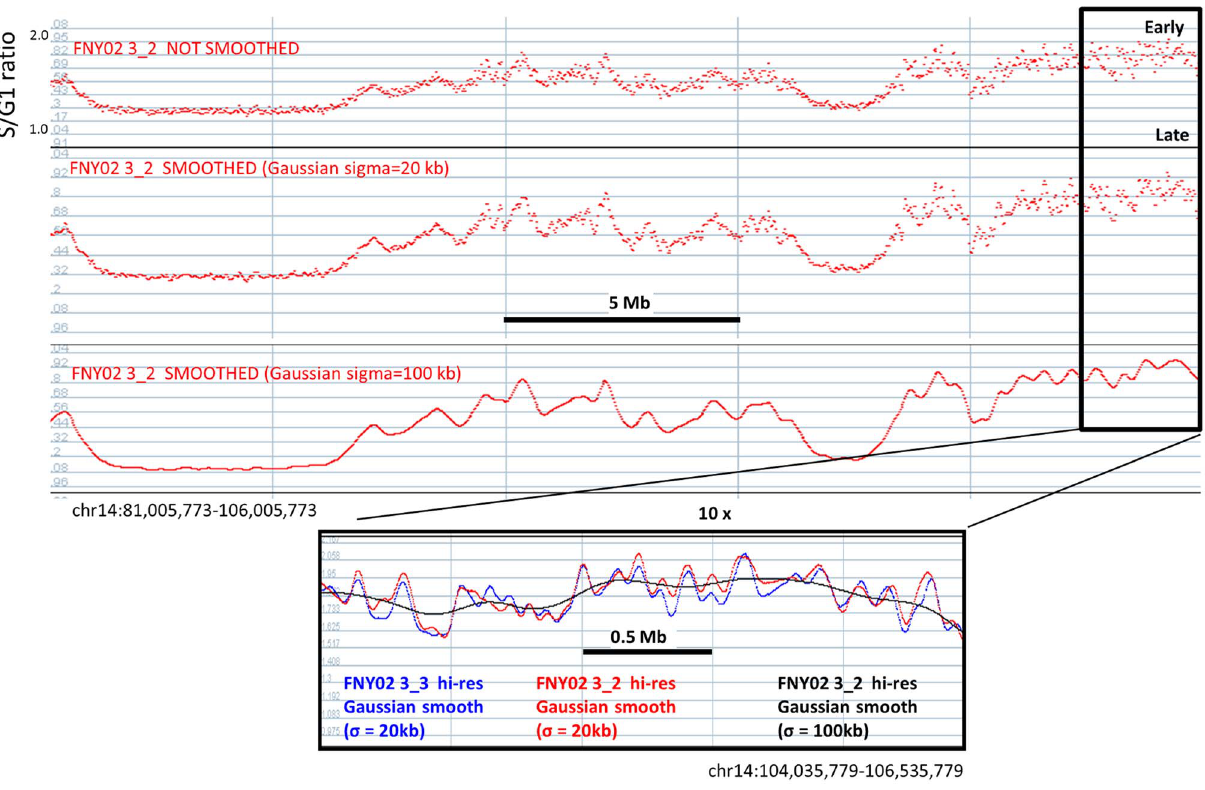
Figure 4. Hi-resolution TimEX-seq analysis reveals the fine structure of the timing domains. 25 Mb region on chr 14 illustrating high- resolution TimEX profiles. Top panel: S/G1 ratios calculated every 1 kb are plotted. At this read depth, the shape of the timing domains can be distinguished without any smoothing. Middle and bottom panel: same data after Gaussian smoothing using sigma=20 Kb or 100 kb. Smoothing at 100 kb, which was necessary to obtain reproducible profiles after read-depth at a low read depth or with micro-array based methods, reveals the major timing domains but smooth the details out. Inset: red curve: TimEX profile after 20 Kb Gaussian smoothing for individual FNY01 3_2; black curve: same data after 100 kb Gaussian smoothing; blue curve: TimEX profile for individual FNY01 3_3 after 20 kb Gaussian smoothing. Note the reproducibility sub-peaks or ripples in the profiles of FNY01 3_2 and 3_3 and how the 100 kb processing masks the details.